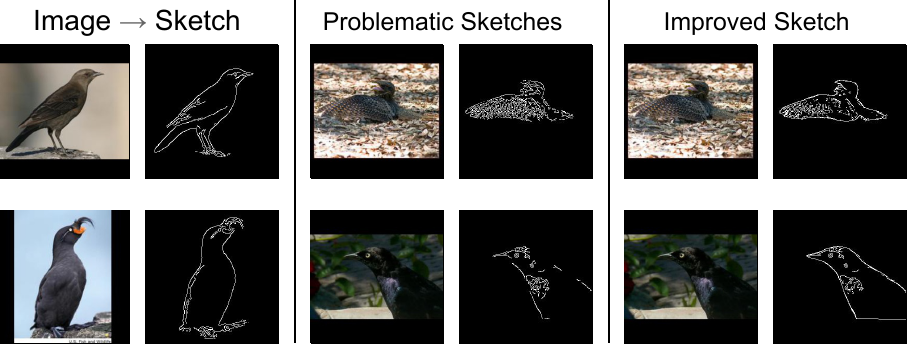
Figure 7. Sketch generation outcomes and the related issues are reported. Our algorithm efficiently deals with complex